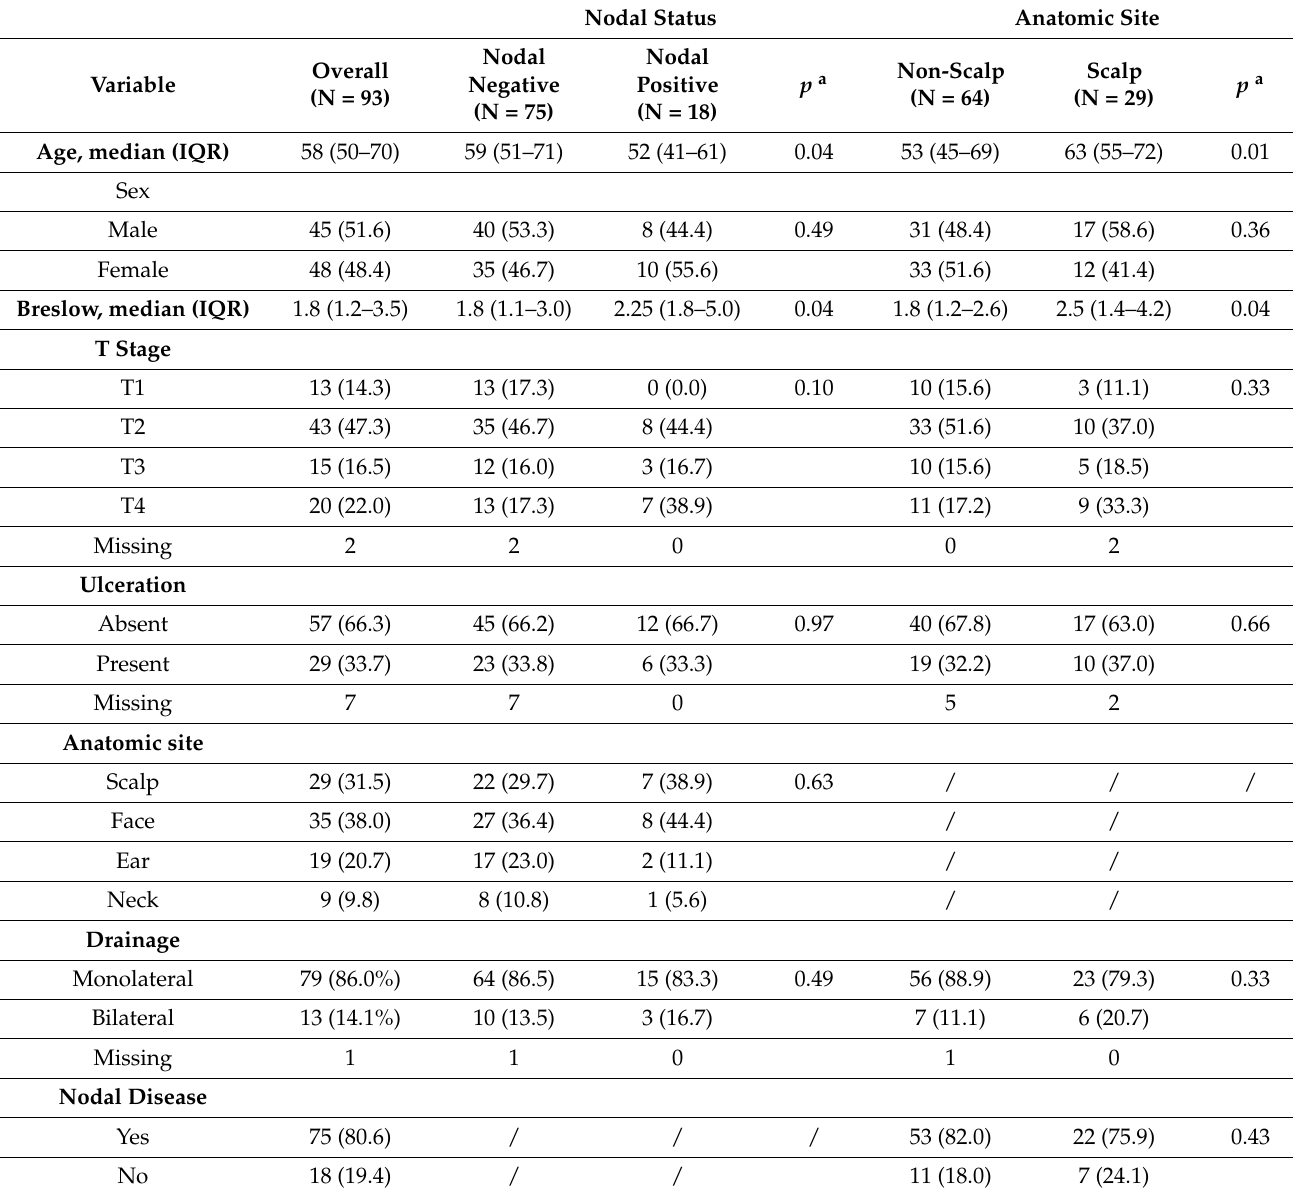
Table 1. Demographic and clinicopathological characteristics of the study population, stratified by sentinel lymph node biopsy status and anatomic site. Nodal Status Anatomic